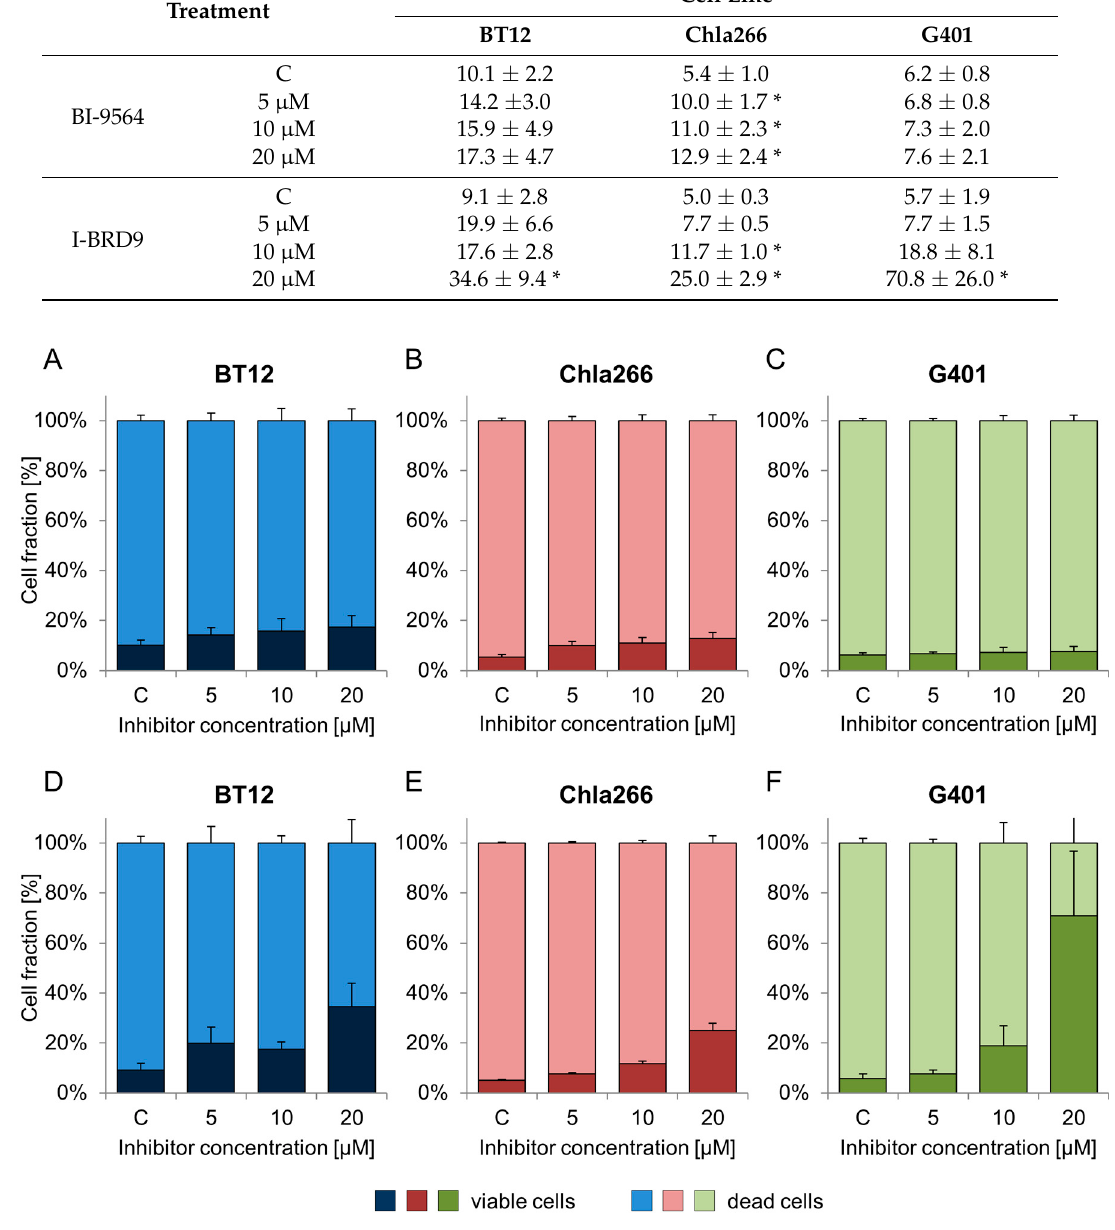
Table 3. Percentage of dead RT cells after incubation with different BI-9564 and I-BRD9 concentrations for 72 h. ( n ≥ 3; mean ± SD, * treatment vs. control with p < 0.05, one-way ANOVA).